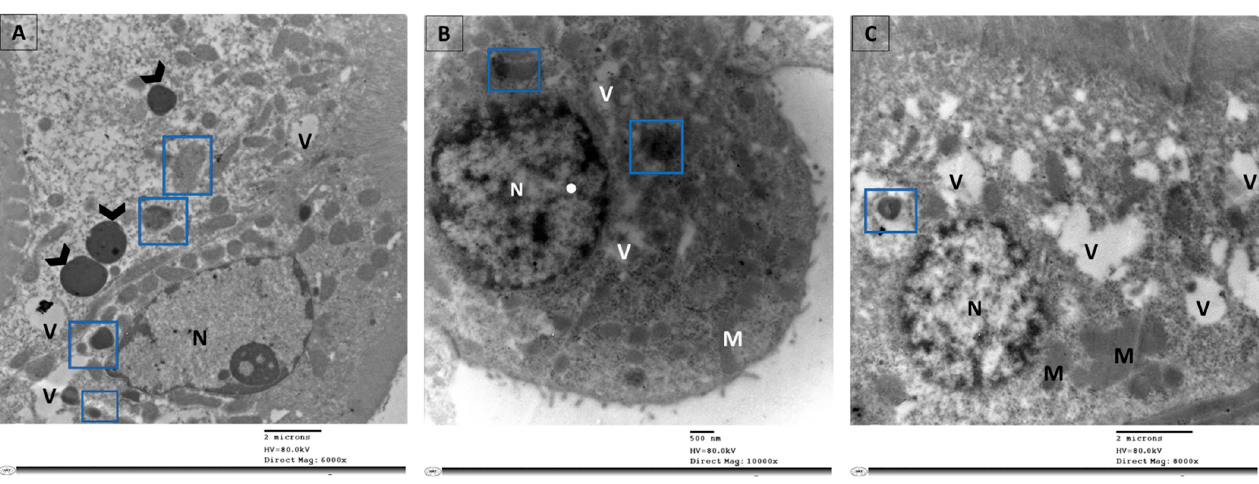
Figure 7. Selected micrographs by TEM of renal cells in the STZ group demonstrated active apoptosis with absence of autophagy. Active apoptosis appeared as apoptotic bodies (arrowhead) which are packages of fragmented intracellular components. Cytoplasmic gaps and swollen or irregular mitochondria (M) were abundant. ( A ) Apoptotic bodies (arrowhead) are mainly the results of splitting of the cellular content into distinct membrane-enclosed vesicles. ( B ) Apoptotic bodies as the result of plasma membrane blebbing (arrowhead). ( C ) Empty cytoplasm along with apoptotic bodies of larger size (arrowhead) and in close approximation to the nucleus (N) suggest inclusion of macromolecules such as proteins, lipids, RNA, and DNA.